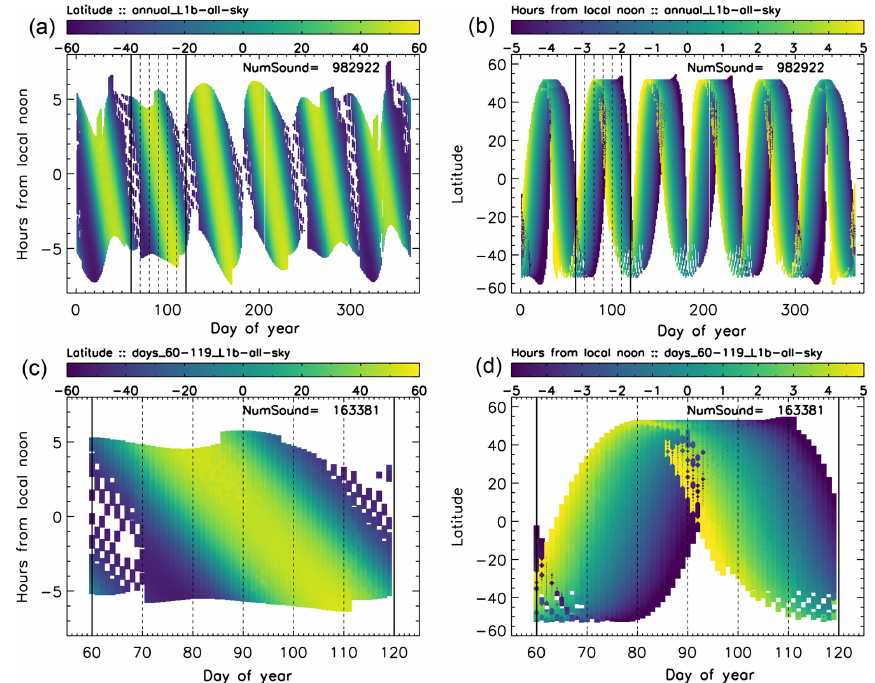
Figure 4. Hovmöller plots showing the observation latitude versus day of year and sampling time relative to local noon (a) and the time relative to local noon versus DOY and latitude (b) for the full year of simulations. Panels (c) and (d) show subsets highlighting the patterns across days 60 to 119. Values should be inflated by 240 to reflect real expected sounding densities at the full spatial (eight footprints per frame) and temporal (3Hz) acquisition